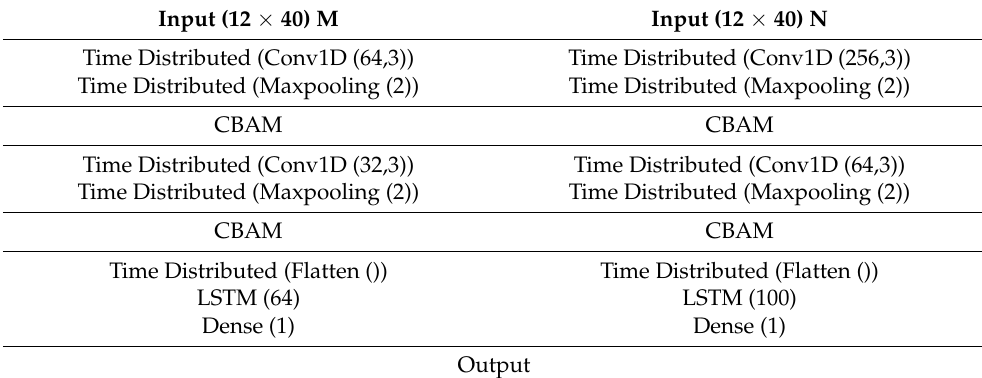
Table A4. Structure and parameters of the CMLA combined